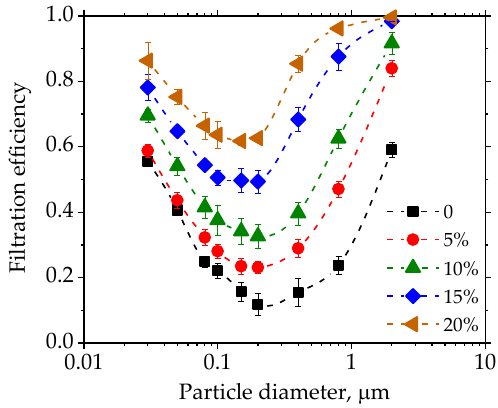
Figure 7. Fractional efficiency of filter paper with different fractions of nanofibers.